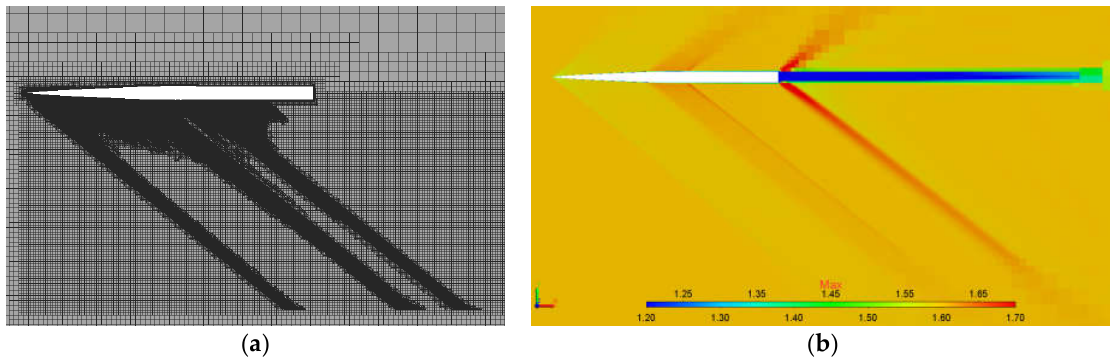
Figure 15. ( a )The third-level adaptive grid ( b ) Mach number field. To generate grids of adaptation levels 1, 2, and 3, a typical size of cells in the local refinement region was 0.003 m, 0.0015 m, and 0.0005 m, respectively. According to results of each numerical test, the normalized static pressure variation along the characteristic line under the object at a distance of 0.65 m was estimated (see scheme in Figure 16) [26].